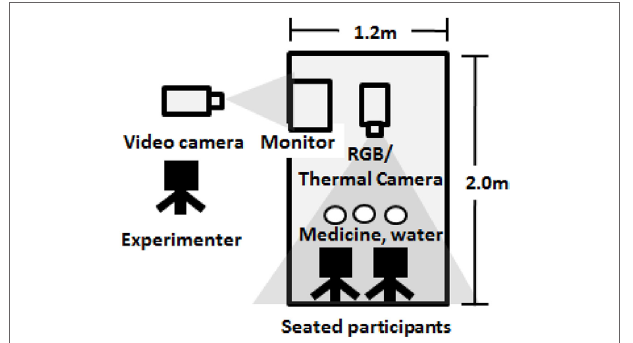
FigUre 10 | Experiment setup for second